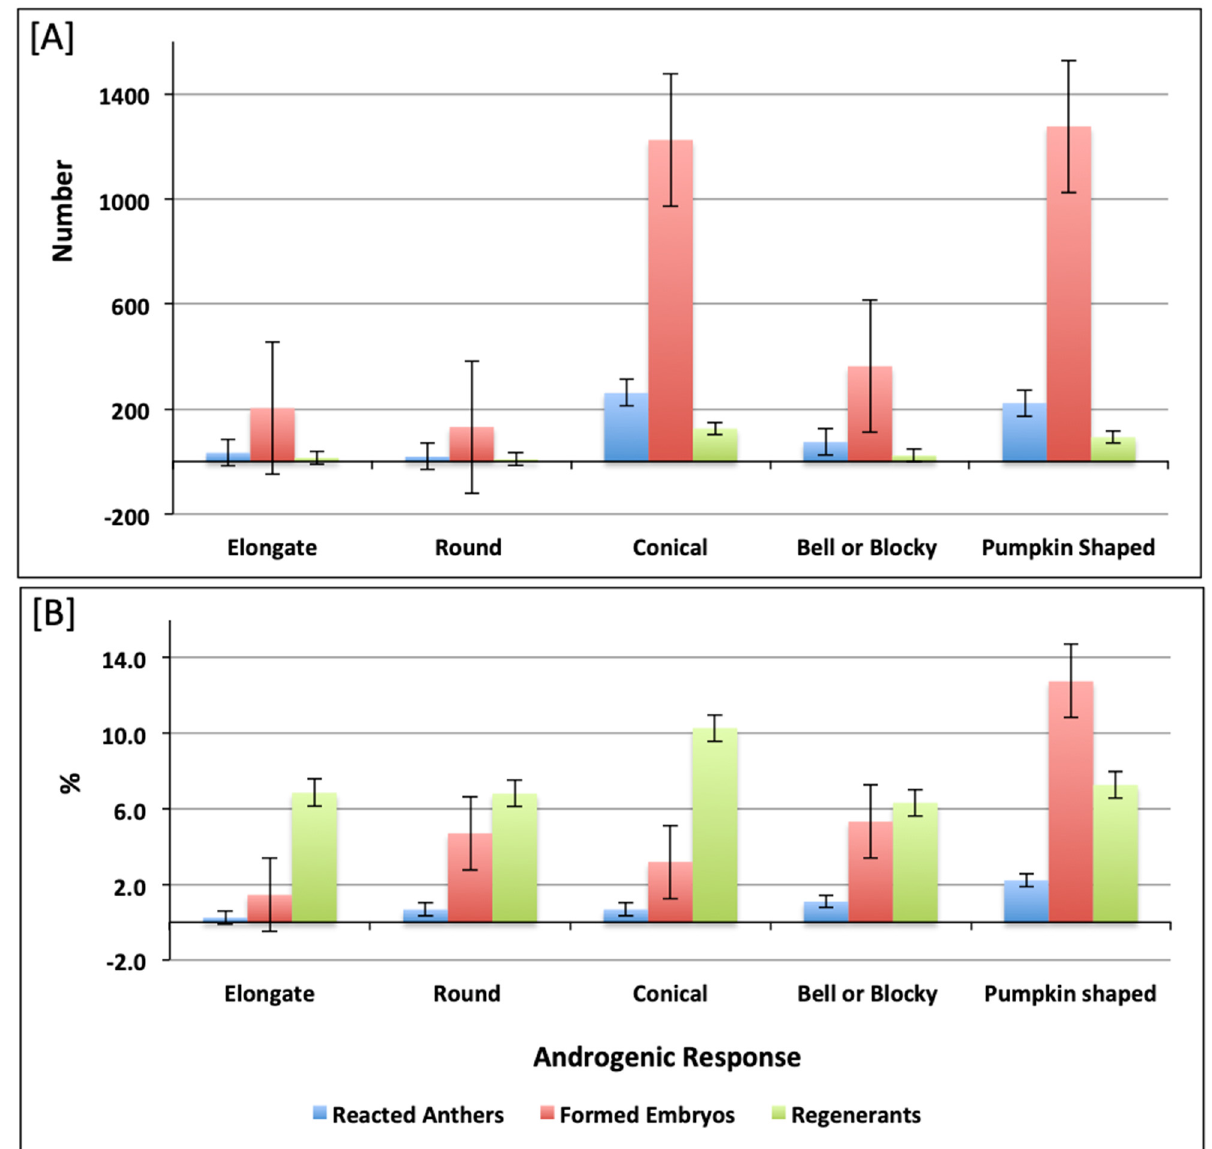
Figure 3. Histogram depicting reacted anthers, formed embryos, and embryo regenerants in accessions belonging to respective varietal groups. The reacted anthers, formed embryos, and embryo regenerants measured in number and percentage (%) are presented in ( A , B ), respectively.